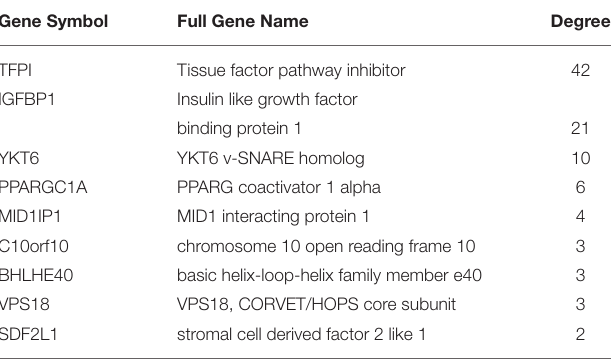
TABLE 2 | Neighbors of ANGPTL8 in its co-expression